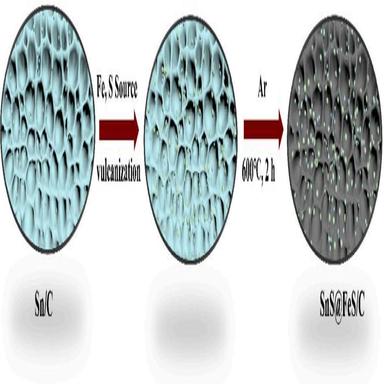
Schematic diagram of the manufacturing process of SnS@FeS/C composite.